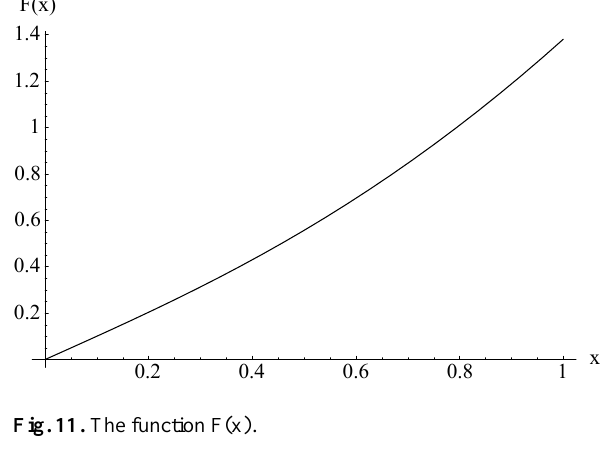
Fig. 11. The function F(x).